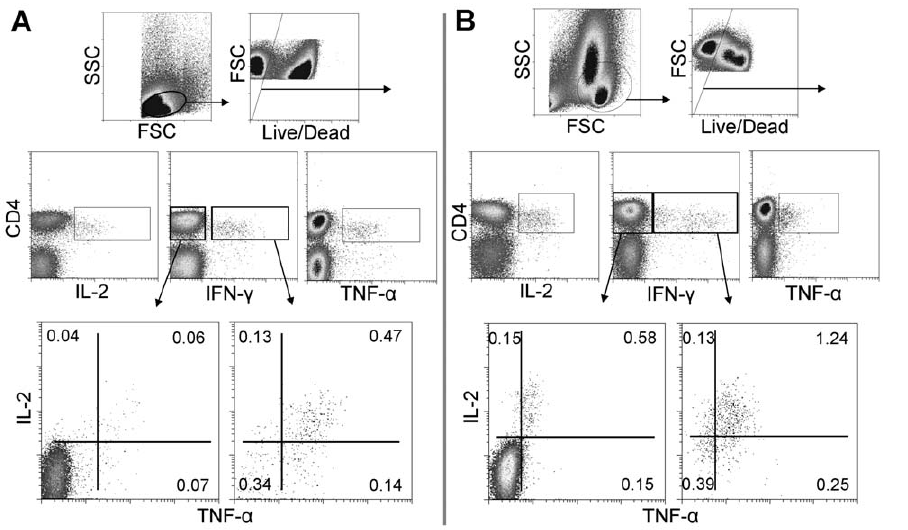
Figure 1. Identification of CD4 + T cells producing IFN- c , IL-2 & TNF- a . Mouse splenocytes 6 weeks following a BCG immunization (A) and PBMC from cattle naturally infected M. bovis (B) were isolated, stimulated with antigen, stained by intracellular cytokine staining (ICS) and interrogated by flow cytometry. Plots were gated on live CD4 + lymphocytes and analyzed for all combinations of simultaneous IFN- c , IL-2 and TNF- a productivity. Numbers indicate percentage of CD4 + cells in the seven individual cell subsets, data are representative of one of three independent experiments.